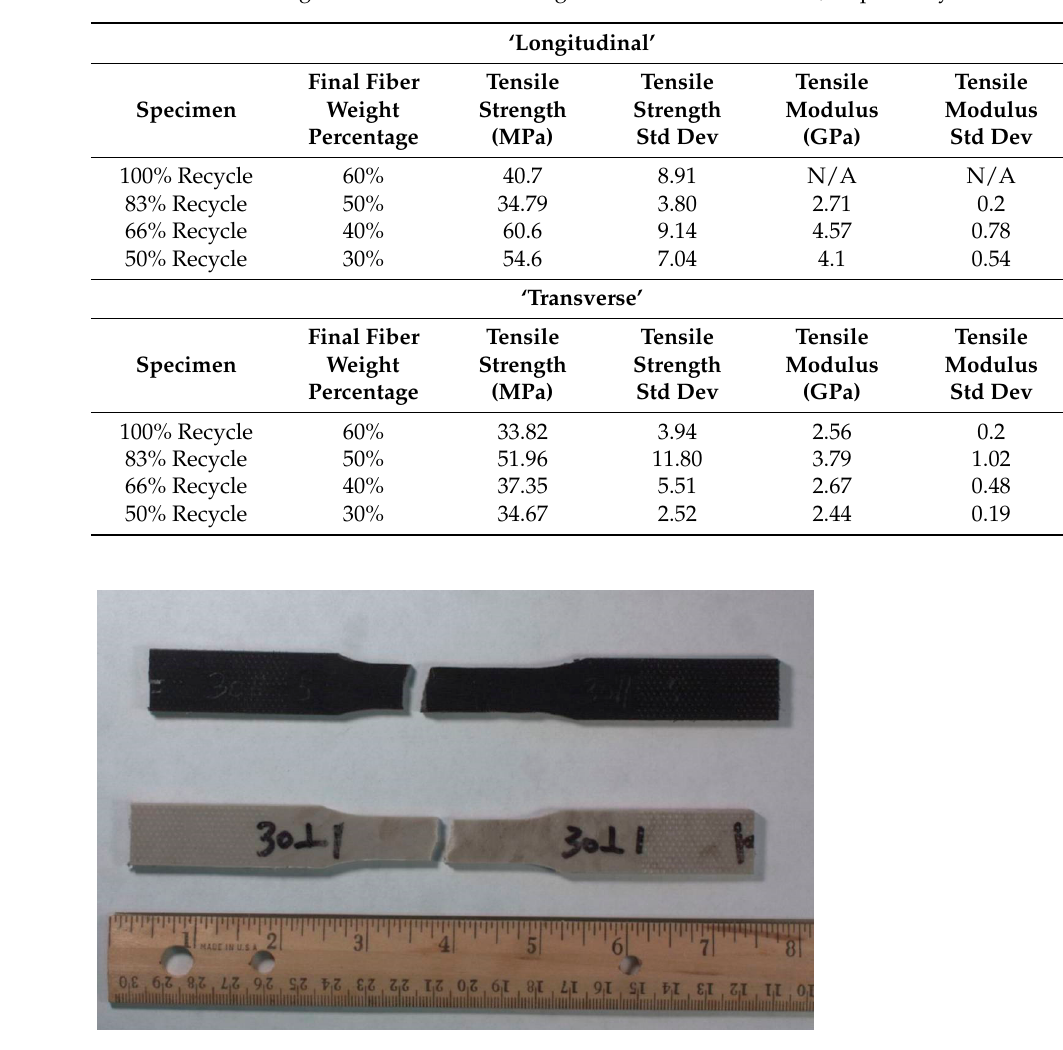
Table 3. Tensile strength and modulus for ‘Longitudinal’ and ‘Transverse’, respectively.